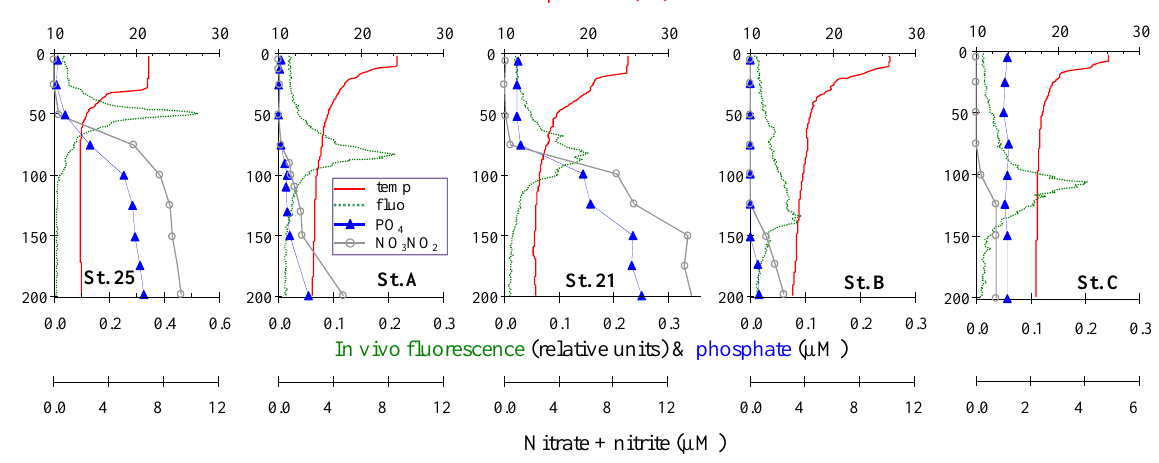
Fig. 3. Vertical distributions of environmental parameters: water temperature (temp, ◦ C), in vivo fluorescence (fluo, relative units), phosphate (PO 4 ) and nitrate+nitrite (NO 3 NO 2 ) concentrations